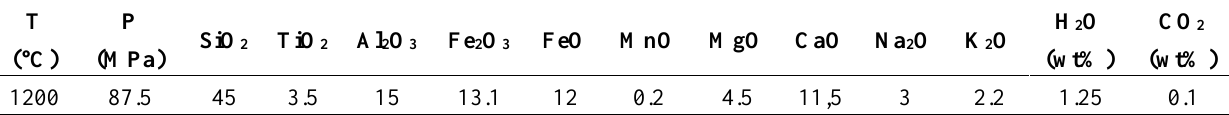
Table 3. Thermodynamics parameters and major and minor element composition considered for the 2010 lavas of Nyamulagira used to compute the weight percent of the exsolved